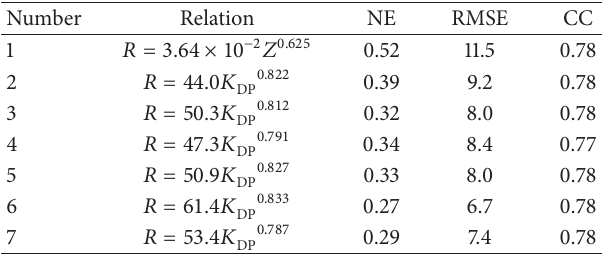
Table 3: Rainfall statistics for the different relations for high rainfall rate conditions for all three cases